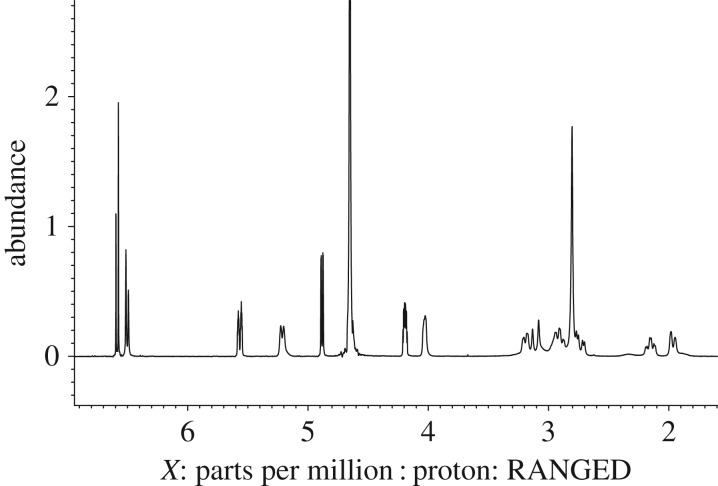
1H NMR spectrum of morphine in D2O.